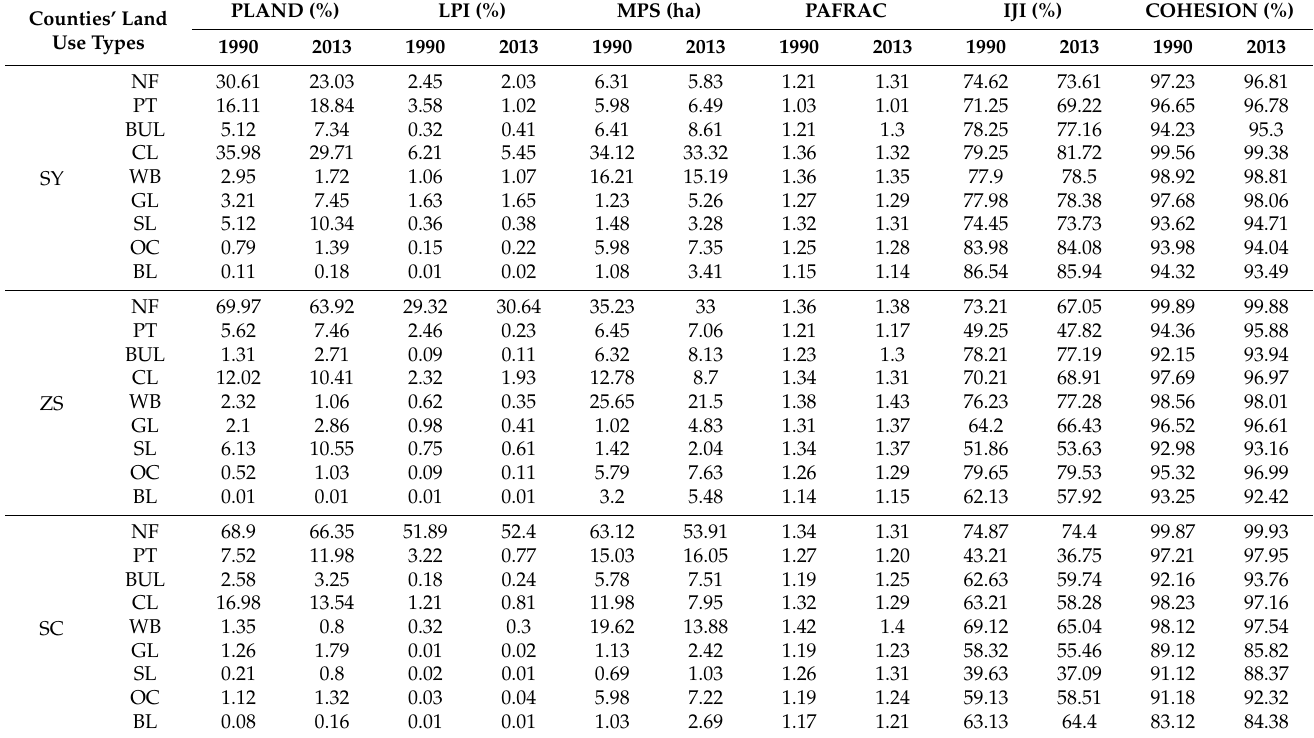
Table 5. Landscape indices of land use types in Shaoyang (SY), Zhushan (ZS), and Shicheng (SC) counties. Counties’ Land Use